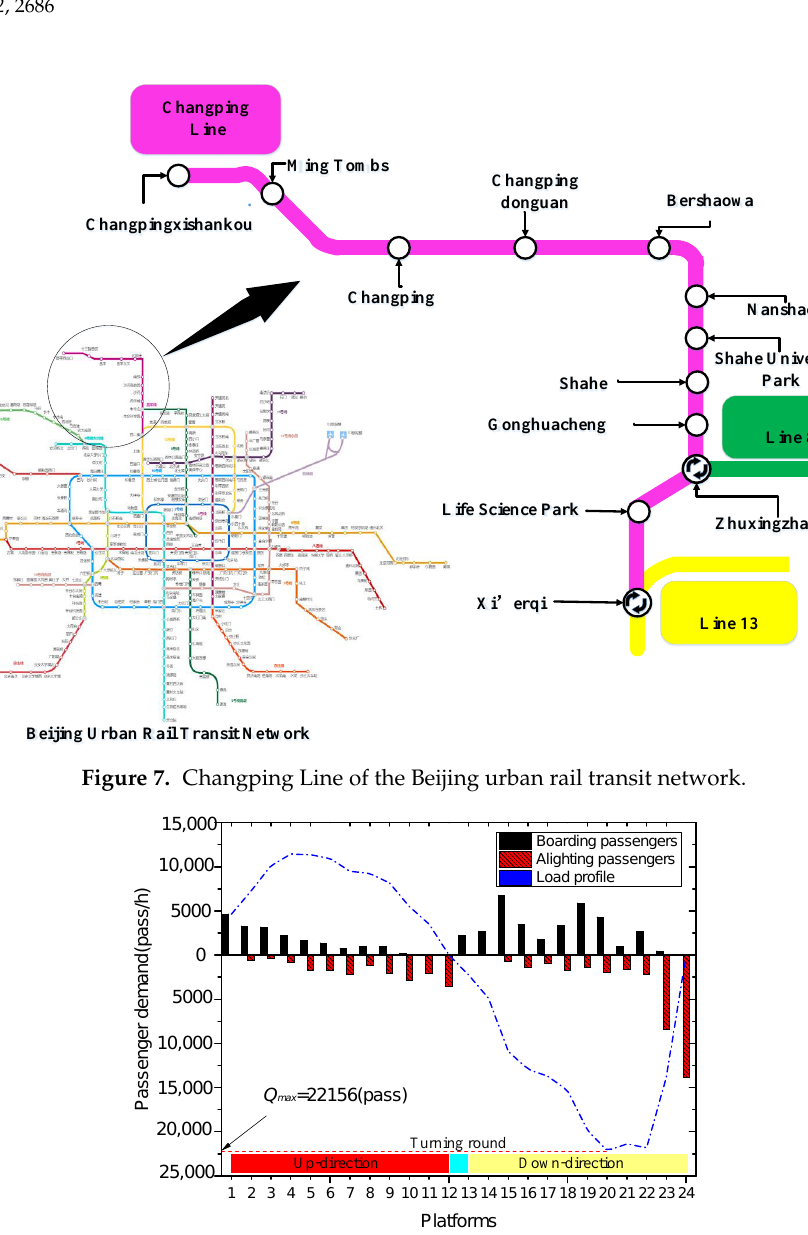
Figure 8. Passenger demand and load profile of each platform during 7:00–8:00.